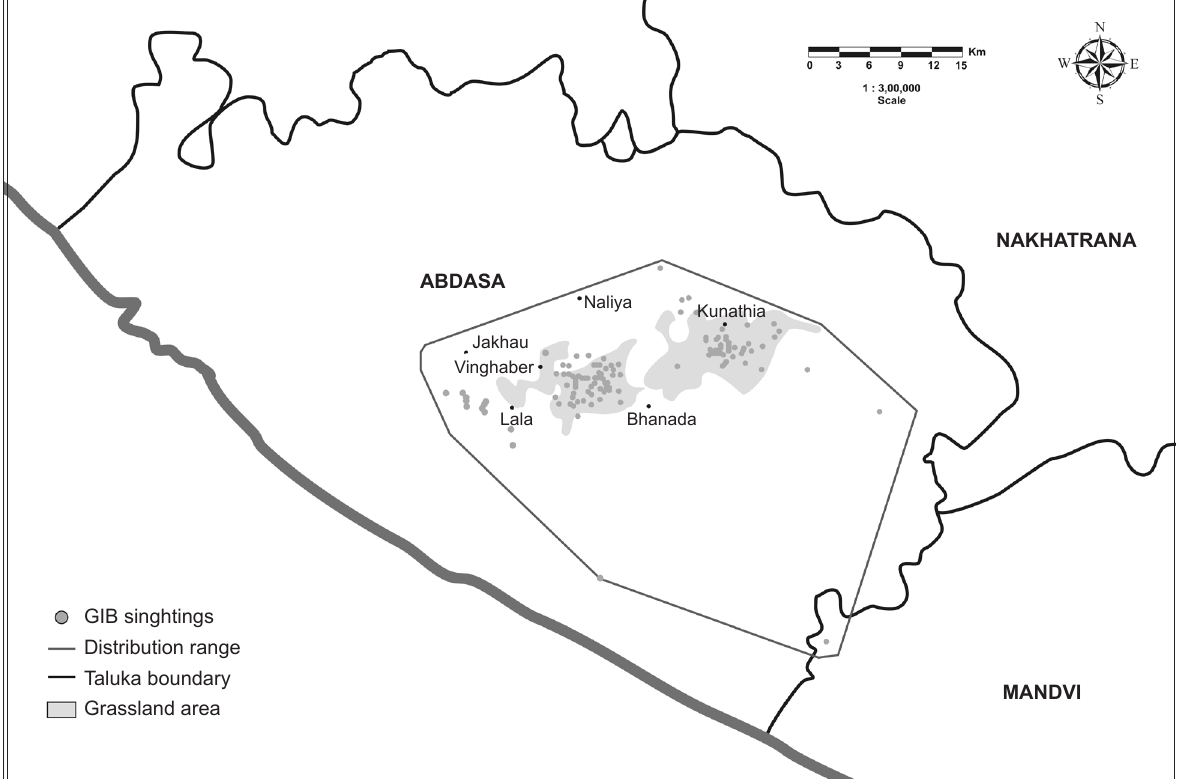
Figure 2. Annual distriution of Indian Bustard in Kachchh (Gujarat) between